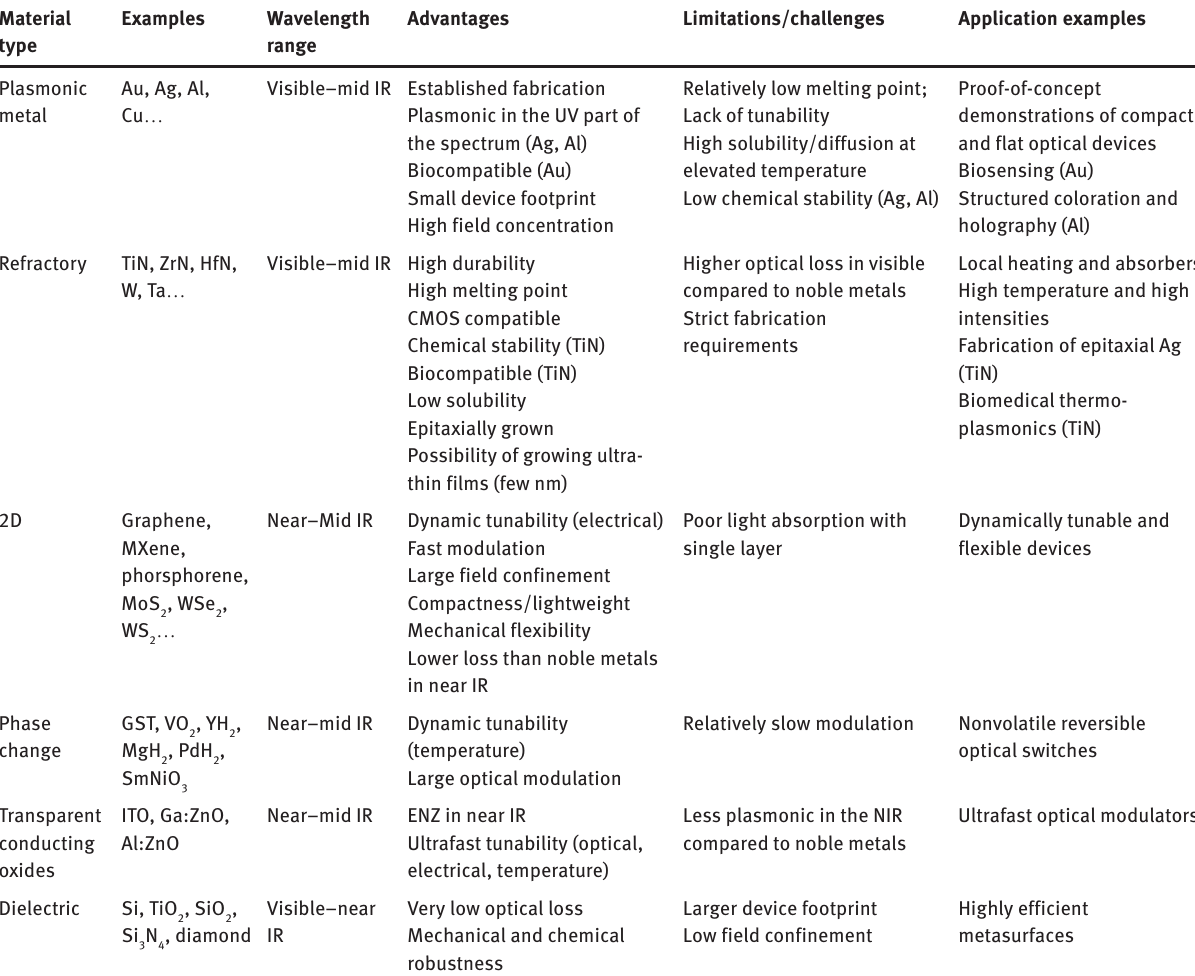
Table 1: Different material platforms with their wavelength range, advantages, limitations and applications.